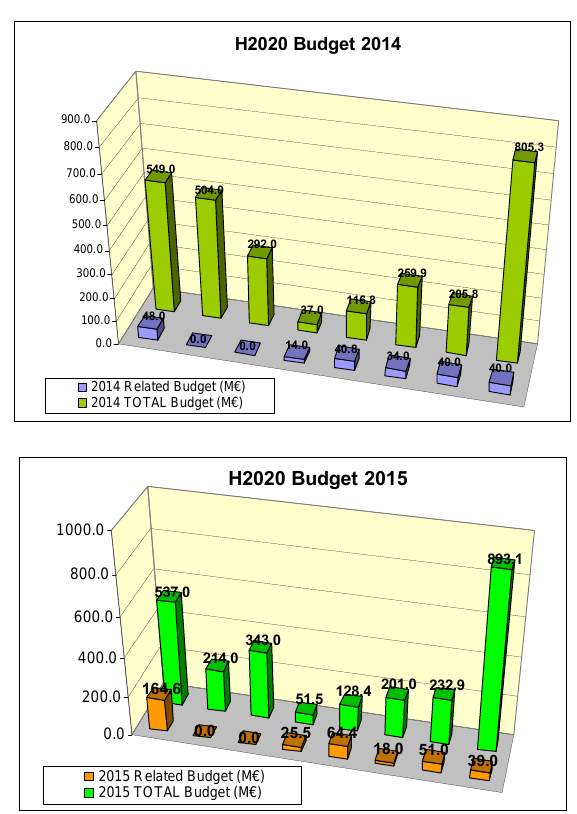
Figure 6. H2020 2014/2015 calls related to “imaging”